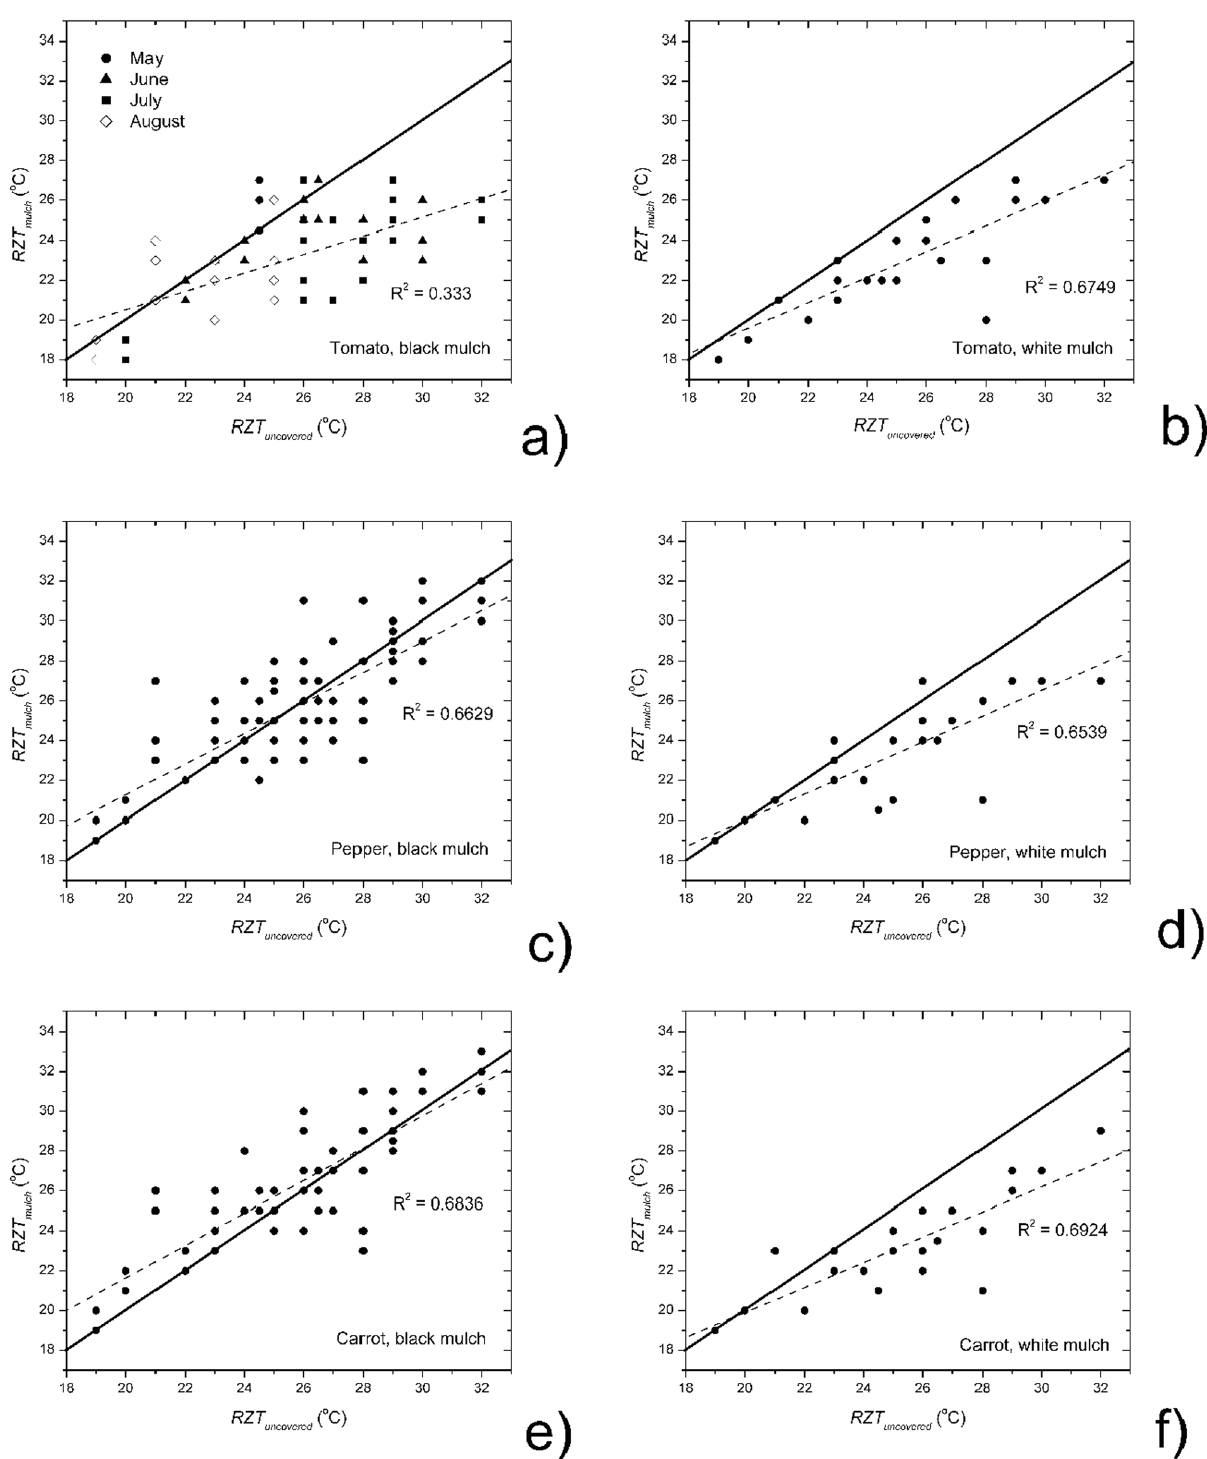
Figure 1: RZT measured in plots covered by mulch as a function of RZT measured in the bare ground plot. Measurements are separated according to the colour of mulch and the plant grown: ( a ) black fi lm with tomatoes, ( b ) white - on - black fi lm with tomatoes, ( c ) black fi lm with peppers, ( d ) white - on - black fi lm with peppers, ( e ) black fi lm with carrots and ( f ) white - on - black fi lm with carrots. In each plot, a solid line with slope equal to 1 is shown, and simple linear fi ts ( dotted lines ) to each dataset are shown, such that data with lines of slope less than 1 indicate plots with temperatures that were less susceptible to ambient temperature change than the uncovered plot. The greatest di ff erence between slopes for the black fi lms is 43% compared to only a 3% di ff erence in slopes for the white - on - black fi lms, suggesting that RZTs under white - on - black fi lms are not susceptible to sunlight but air